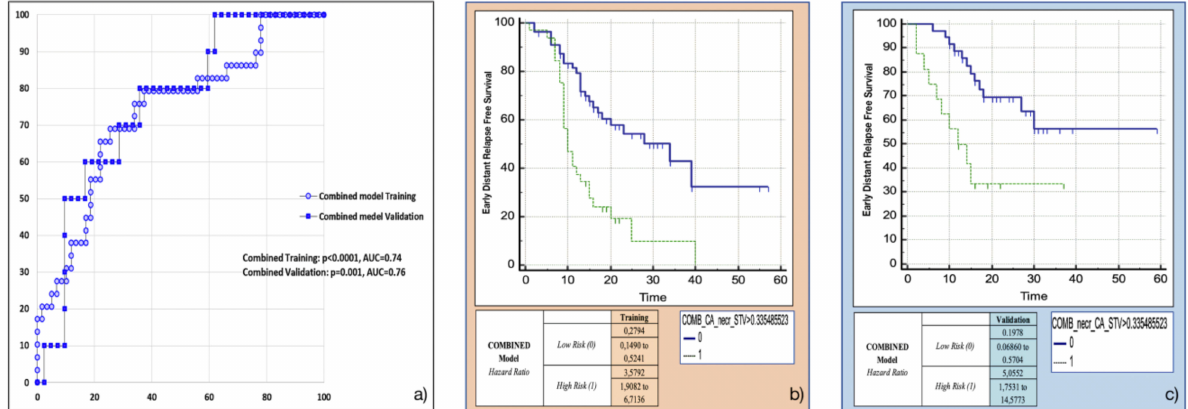
Figure 6. Combined model overall performance in terms of ( a ) area under the ROC curve (AUC) for both training ( blue empty circles ) and validation ( blue filled squares ) cohorts, and outcome prediction in terms of Kaplan Meier curve separation between low and high risk patients according to the computed prognostic index in both training ( b ) and validation ( c )